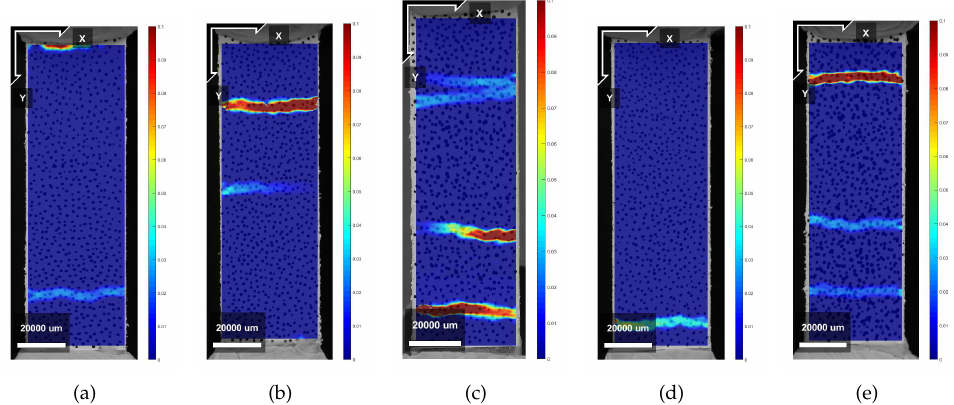
Figure 11. Crack pattern obtained from DIC analysis on Y samples—Vertical Deformations. ( a ) Specimen 1; ( b ) Specimen 2; ( c ) Specimen 3; ( d ) Specimen 4; ( e ) Specimen